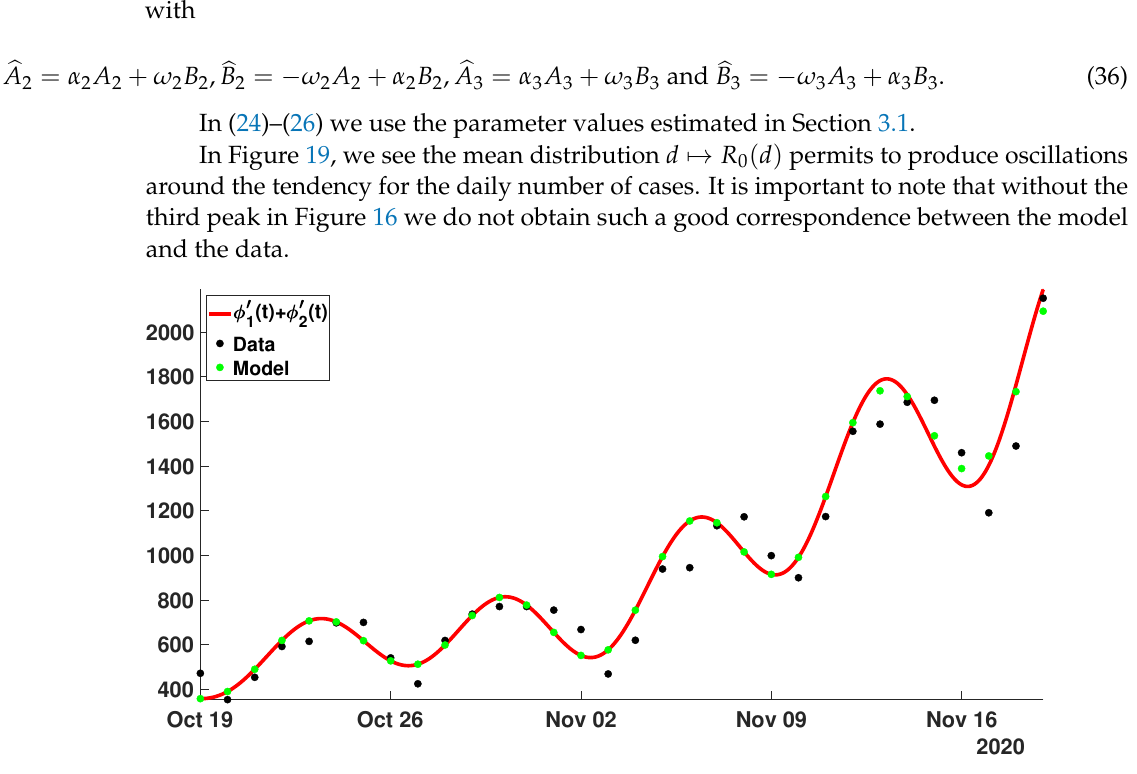
+ φ (cid:48) , and the green dots corre- 2 1